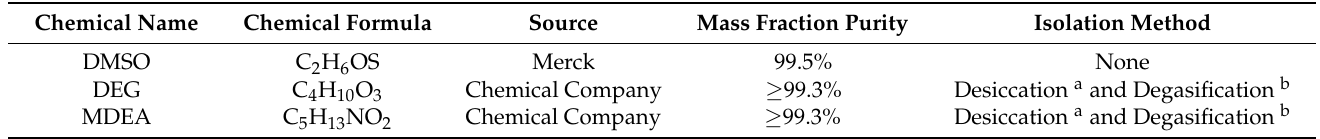
Table 1. Specification of chemical